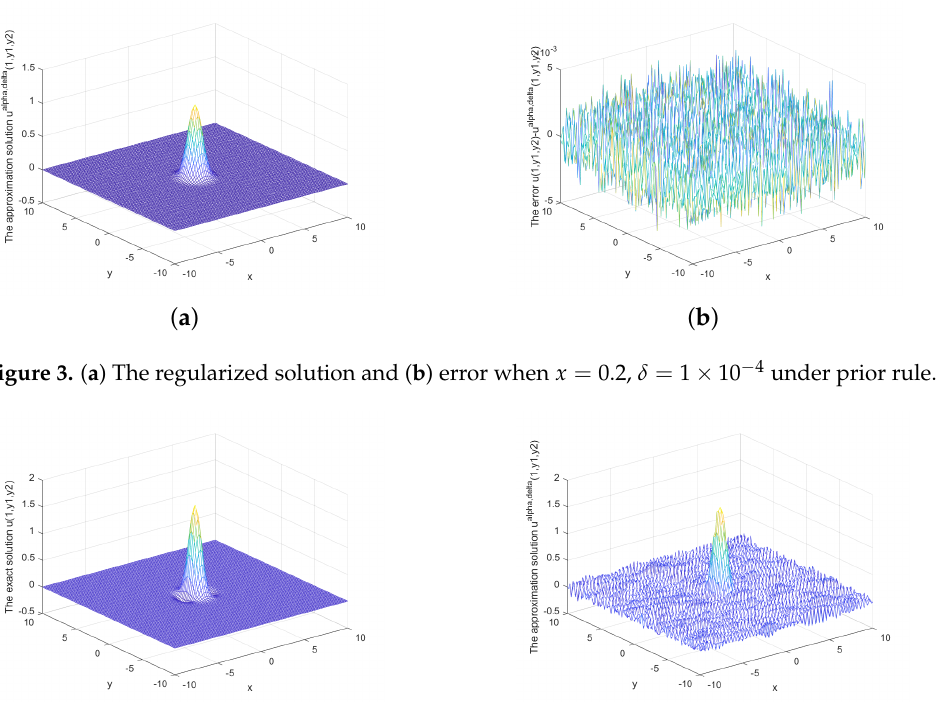
Figure 2. ( a ) The regularized solution and ( b ) error between regularized and exact solution when x = 0.2, δ = 1 × 10 − 3 under prior rule.